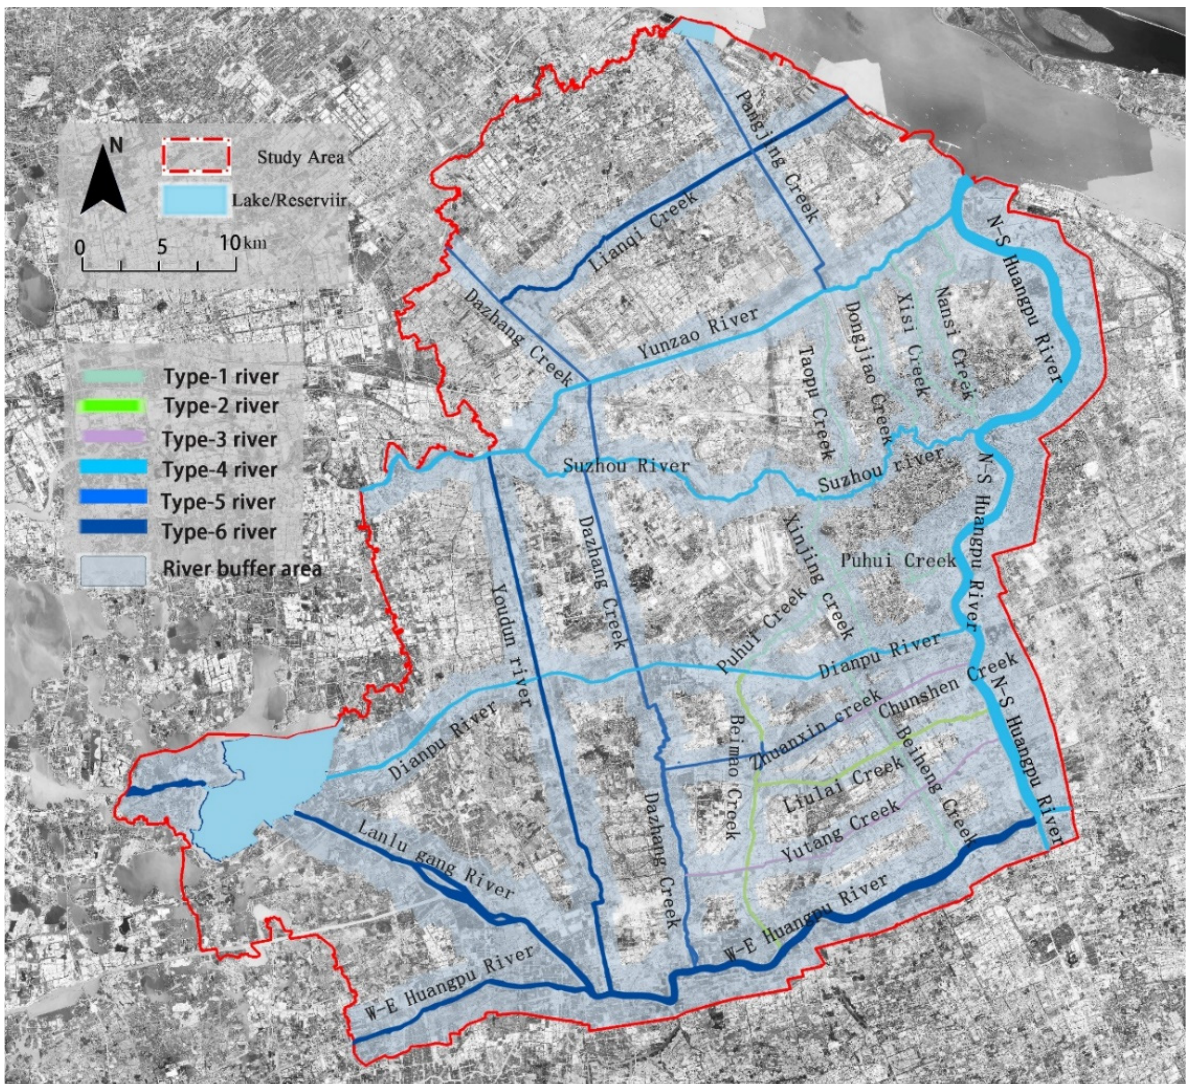
Figure 1. Raster image of the study area and location of the backbone river corridors in Shanghai, China.